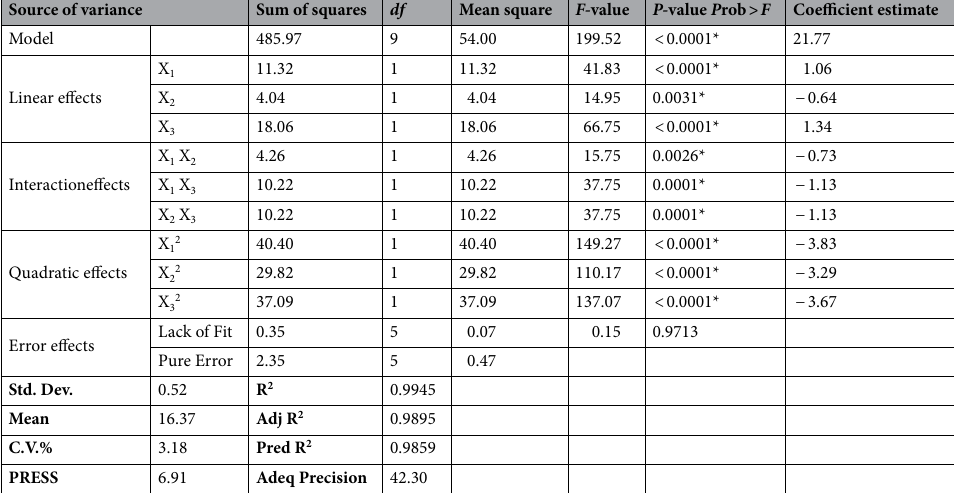
Table 2. Statistical analysis for FCCCD of BNC production. The independent factors are: X 1 (pH); X 2 (Cantaloupe juice; %, v/v); X 3 (incubation time; days). *Significant values F Fishers’s function; P Level of significance; C . V Coefficient of